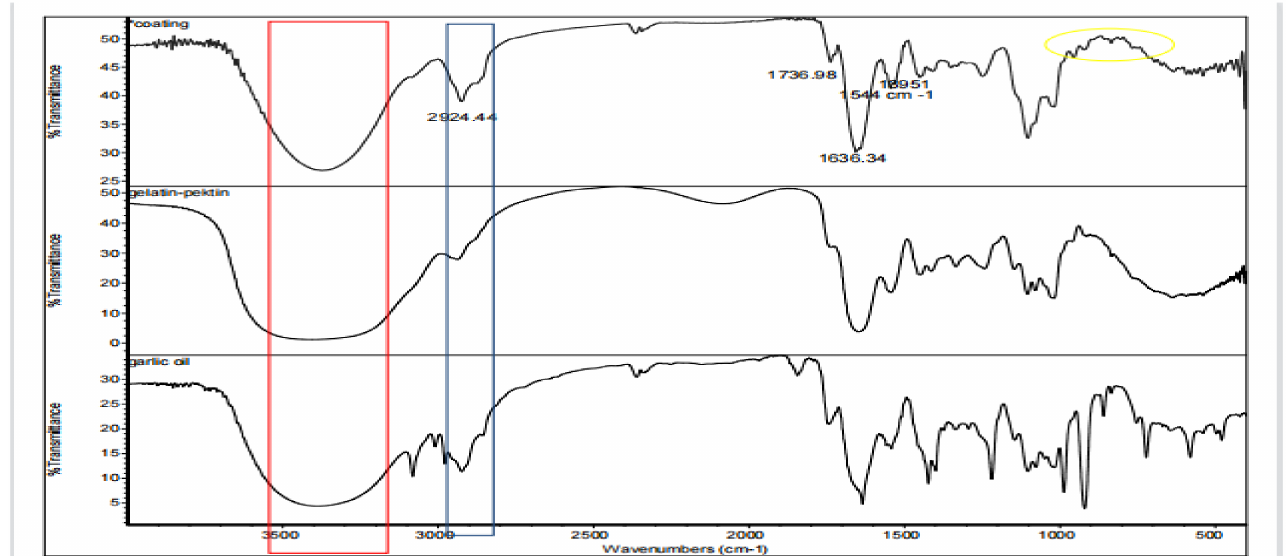
Figure 1. FTIR of an edible coating of Tilapia gelatin composite gelatin–pectin with incorporated garlic essential